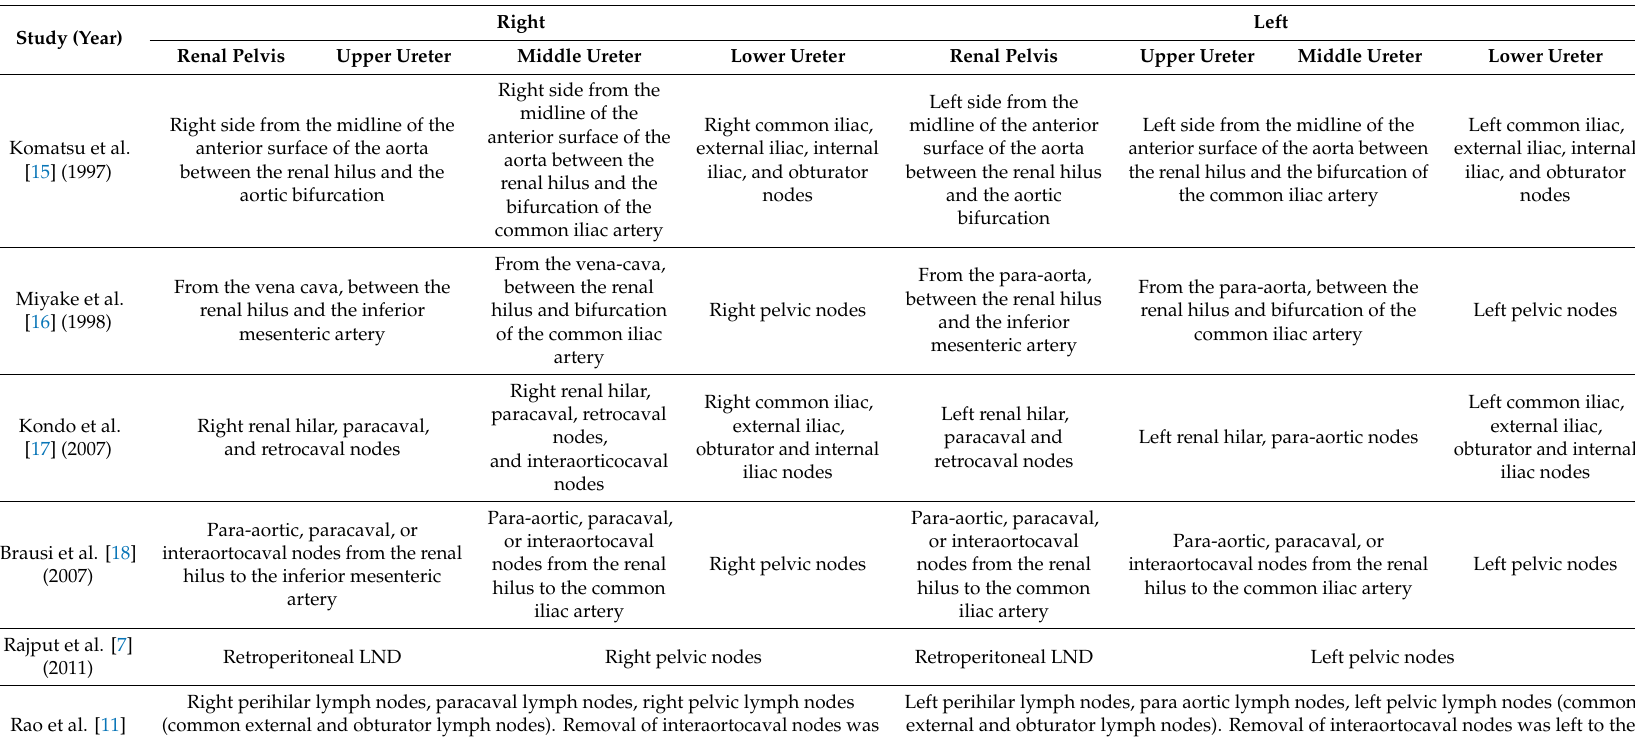
Table 1. Description of anatomical